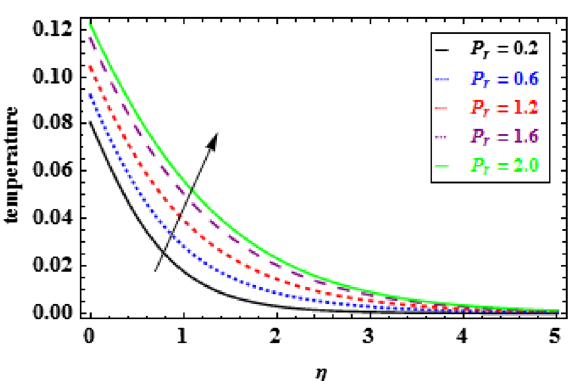
Figure 6. Inspiration of P r on temperature.